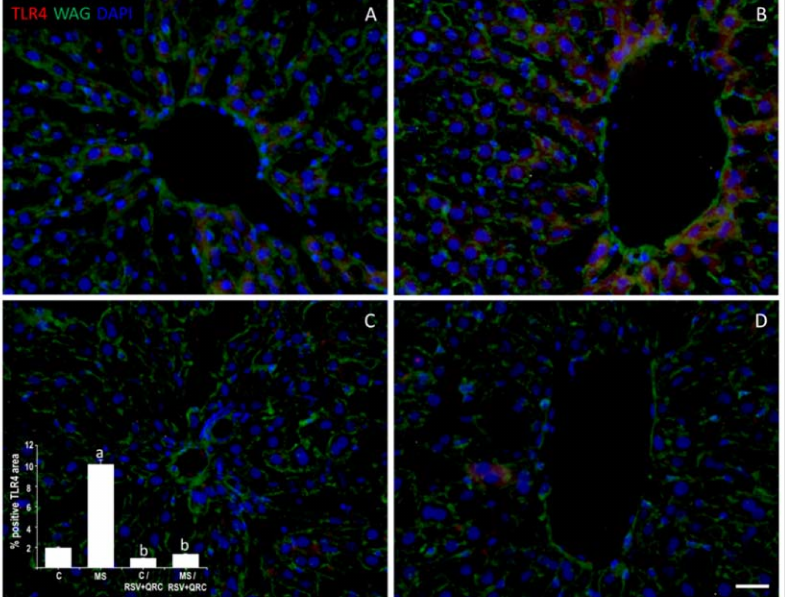
Figure 1. RSV + QRC administration decreased TLR4 expression in the liver from Control and MS rats. The detection of TLR4 immunostaining (red) was located in hepatocytes around of central vein. Wheat germ agglutinin (WAG) labeled with Oregon Green ® 488 was used to label the membranes and 2-[4-(Aminoiminomethyl) phenyl]-1H-Indole-6-carboximidamide hydrochloride (DAPI) for nuclei. The graph with the values of the percentage of positive TLR4 area is in the lower-left corner. a p < 0.05 vs. Control: b p < 0.01 vs. MS group. Panel ( A ) = Control group, Panel ( B ) = metabolic syndrome (MS) group, Panel ( C ) = Control/RSV + QRC group, Panel ( D ) = MS/RSV + QRC group. Bar = 50 µ m.